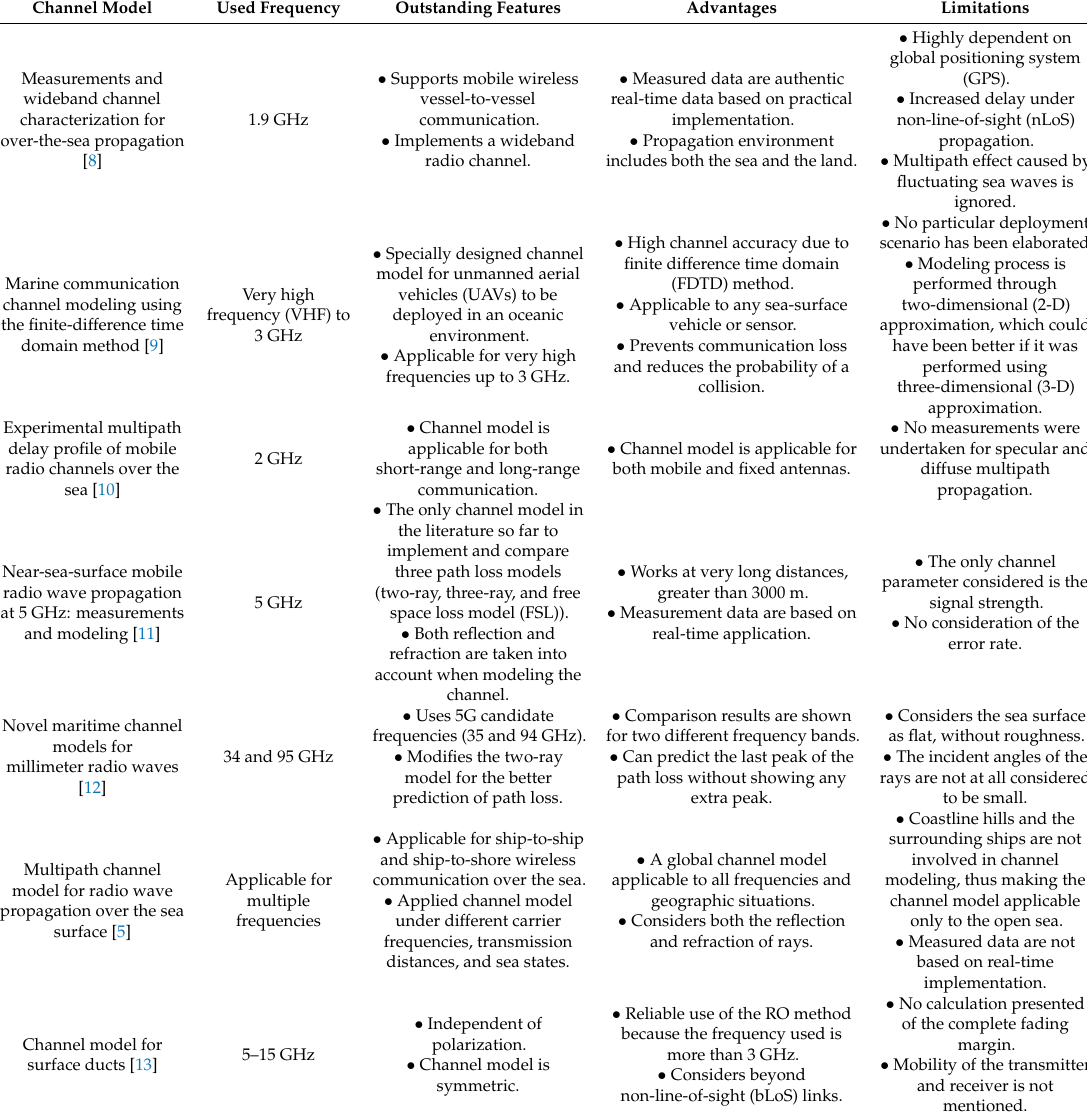
Table 1. Comparison of channel models for over-the-sea wave